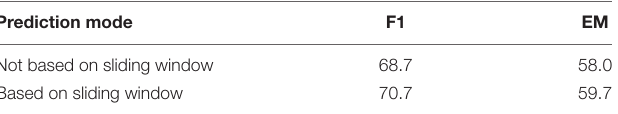
TABLE 6 | Effect verification of output layer based on sliding window prediction method.